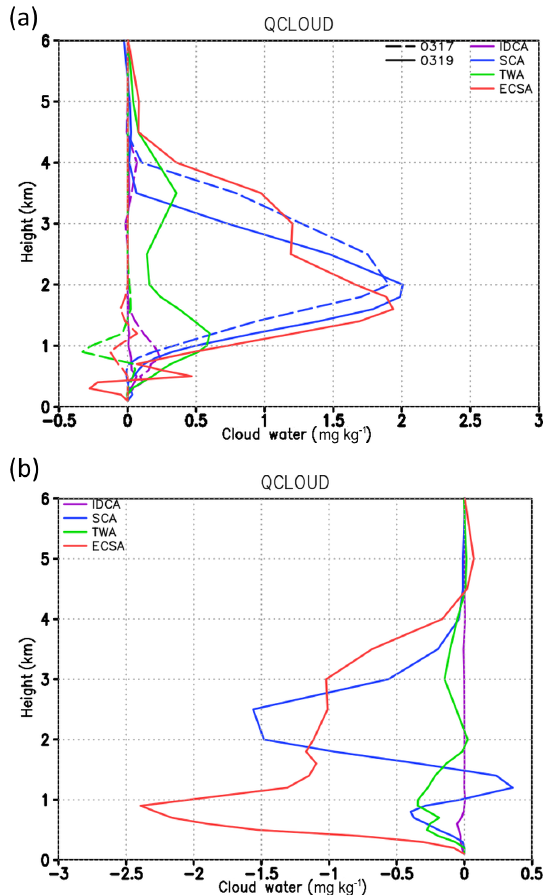
Figure 13. (a) Simulated vertical distribution of BB influences on cloud water difference with and without BB emission on 17 (dash) and 19 (solid) March 2018. (b) Simulated vertical distribution of cloud water difference with and without indirect effect in the model on 19 March 2018. Regions include IDCA, SCA, TWA, and ECSA as shown in Fig.